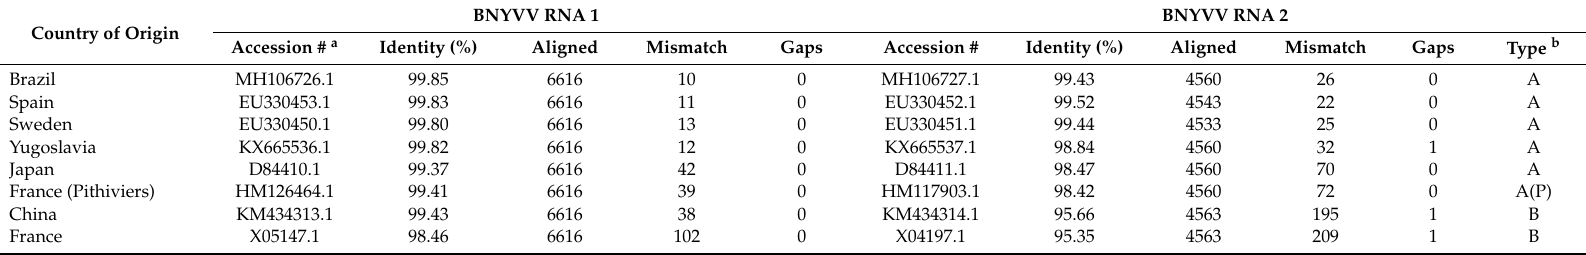
Table 2. Similarity between the US BNYVV consensus sequence for RNA 1 and RNA 2 and cognate BNYVV RNAs from outside the USA. BNYVV RNA 1 BNYVV RNA 2 Country of Origin Accession # a Identity (%) Aligned Mismatch Gaps Accession # Identity (%) Aligned Mismatch Gaps Type